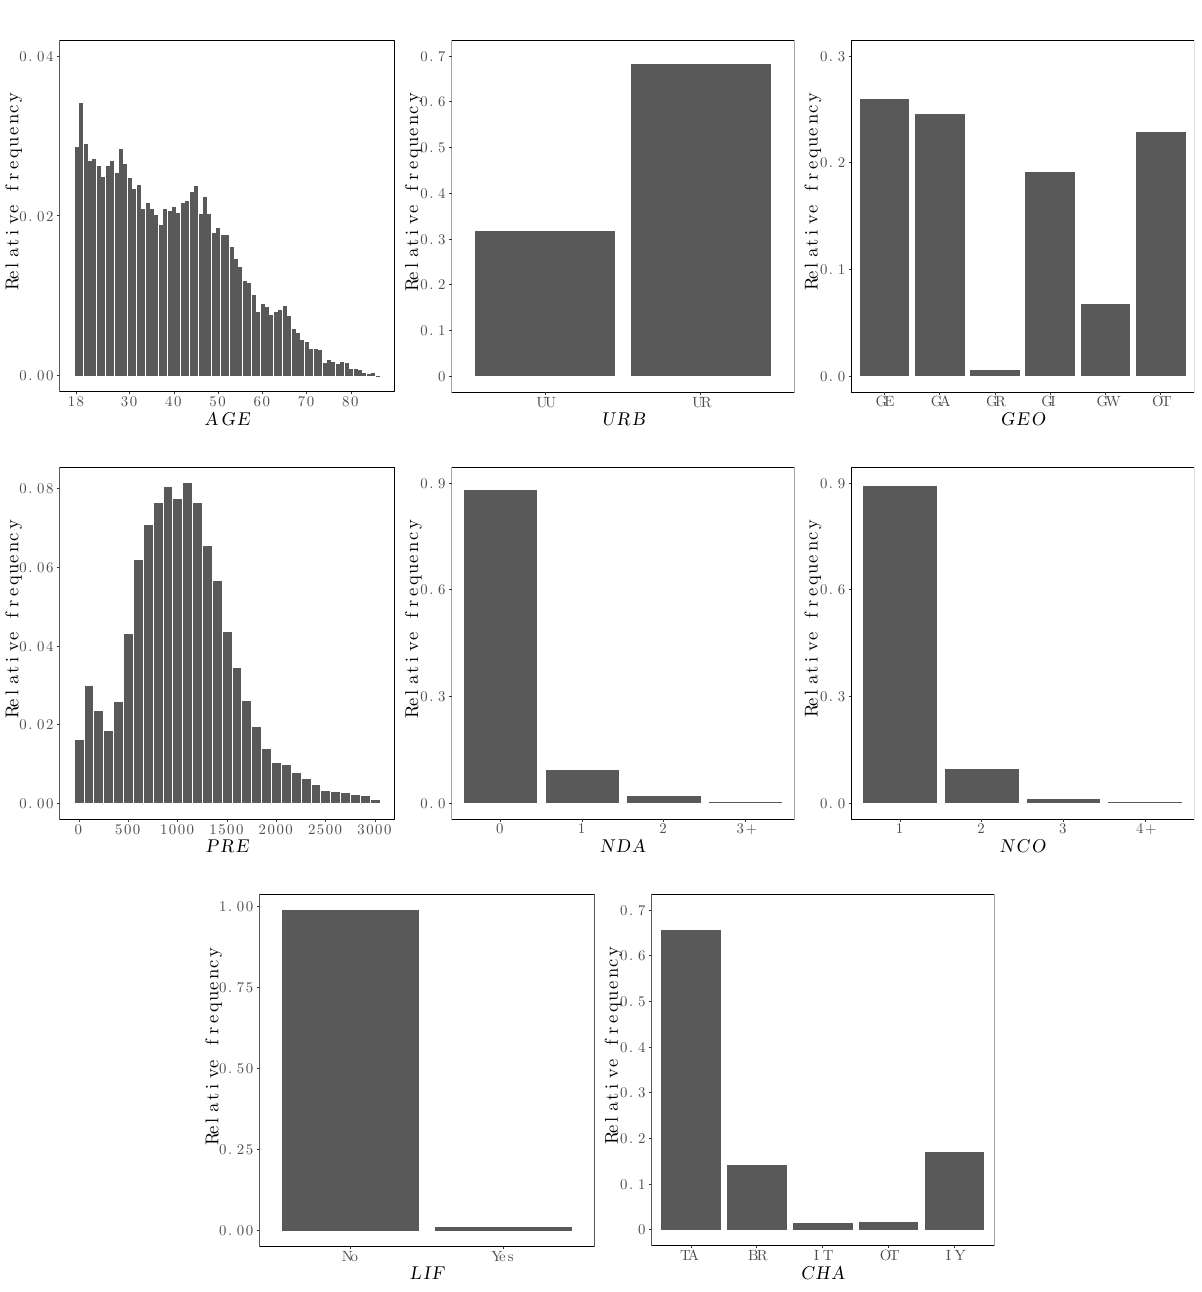
Figure 4. Illustration of the relative frequencies along covariates in the CA